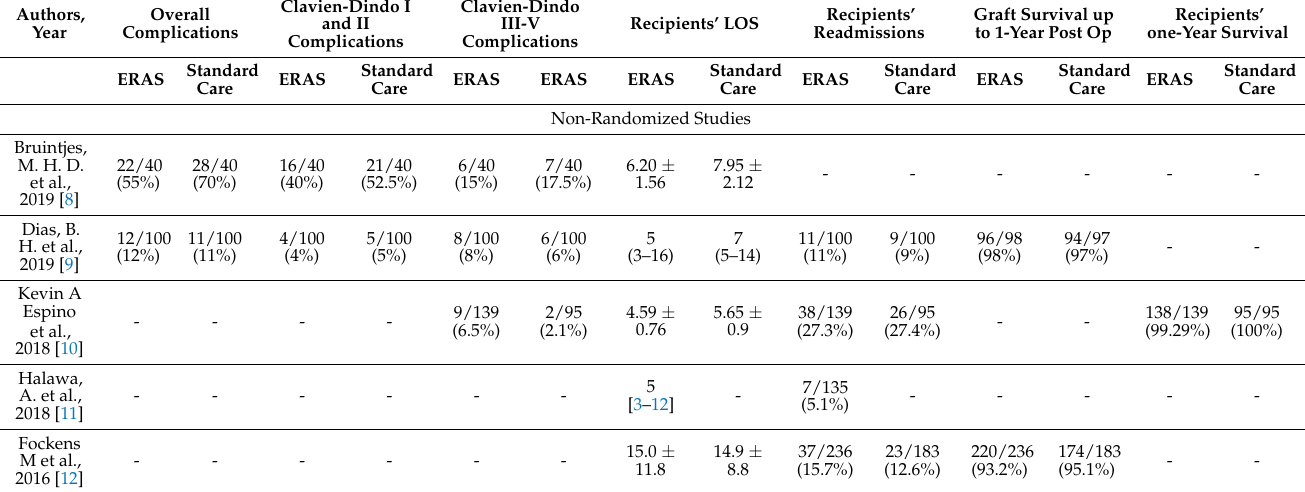
Table 6. Post-operative complications, LOS, readmissions, one-year graft and patient